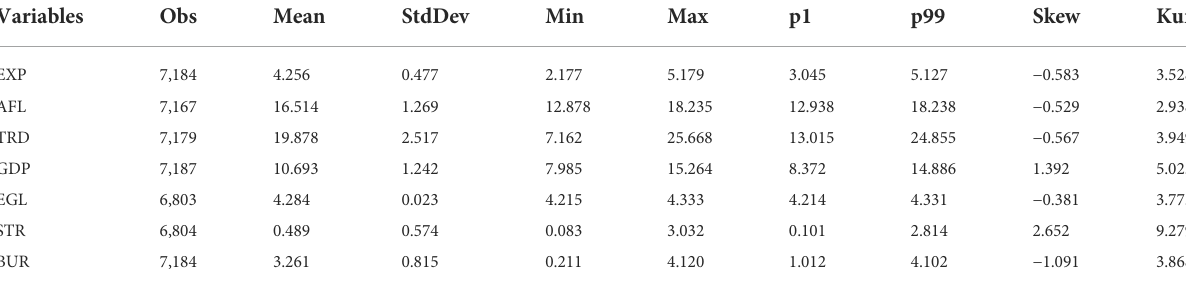
TABLE 1 Statistic description.